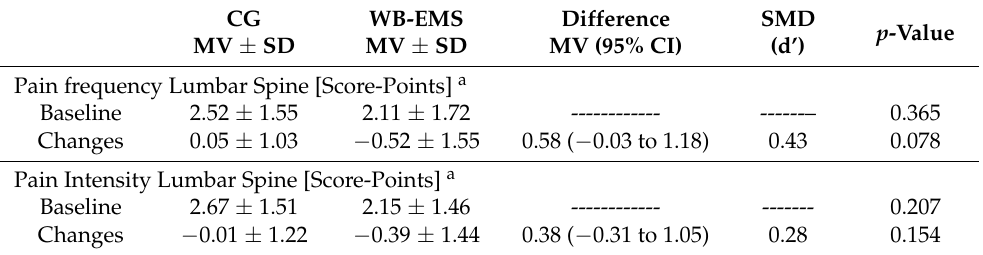
Table 3. Baseline data and changes of pain frequency and intensity at the lumbar spine in the WB-EMS and control